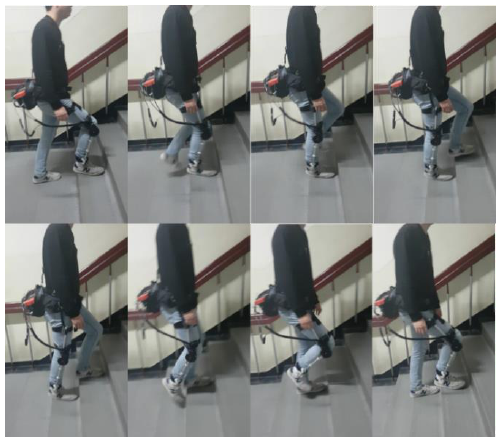
Figure 8. Stair ascending experiment snapshot. The trained NN was tested by ascending stairs while wearing the exoskeleton.